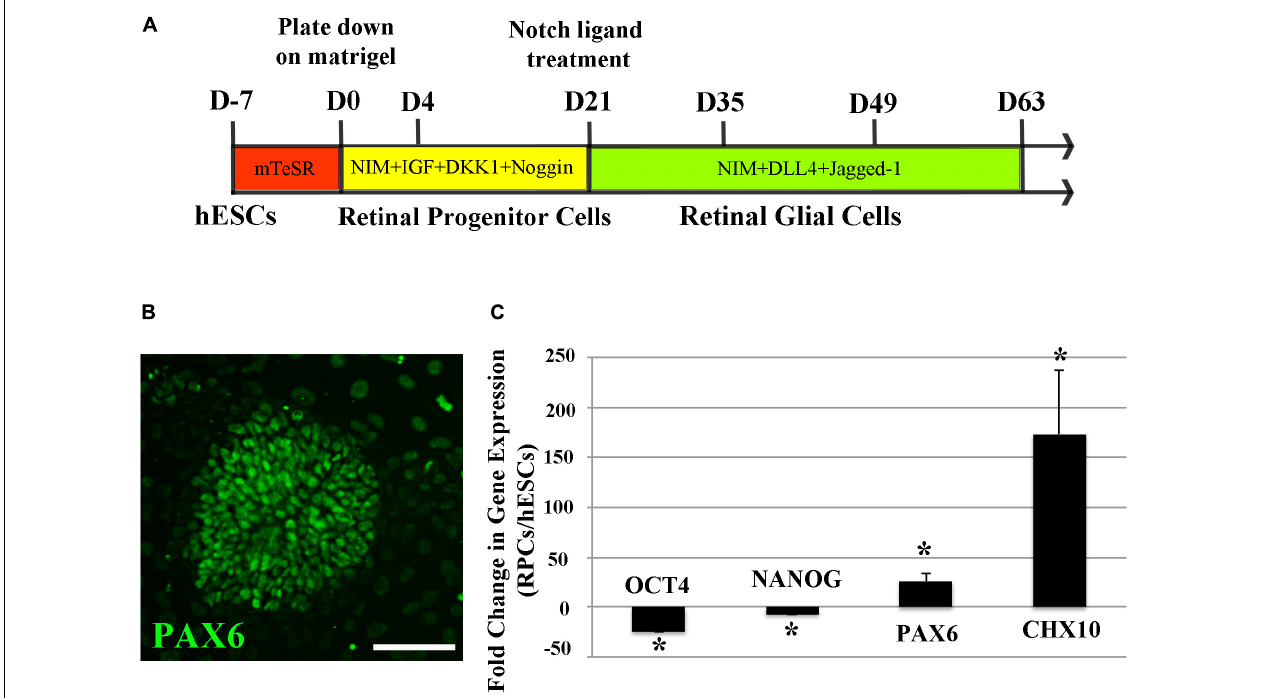
FIGURE 1 | Differentiation of H9 human embryonic stem cells (hESCs) into retinal progenitor cells (RPCs). (A) A schematic diagram illustrating the method of differentiating hESCs to RPCs and glial cells. (B) Immunocytochemistry results showing formation of PAX6 positive retinal progenitors with rosette-like morphology 15 days after culture in the neural induction medium. (C) qRT-PCR analyses 3 weeks after directing hESCs to differentiate into RPCs. Our results indicated significant upregulation of the eye field markers PAX6 and CHX10 along with decreased expression of stem cell markers of OCT4 and NANOG after culturing H9 hESCs in the neural induction medium for 3 weeks ∗ p < 0.05 vs. undifferentiated human ESCs, error bars represent SEM, n = 3/group. Scale bar: 100 µ